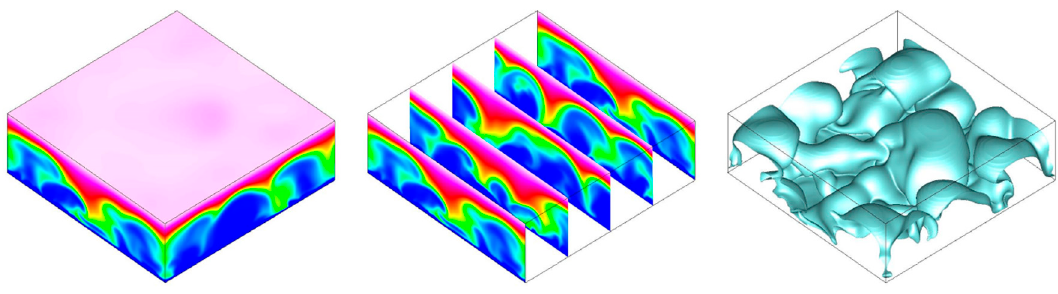
Figure 9. Baseline 3-D case, 𝑉(cid:3560) = 120. Smooth membrane. Iso-contours of anion concentration and iso-surfaces of anion concentration of 0.2 for 𝑡̃ = 0.00056 .